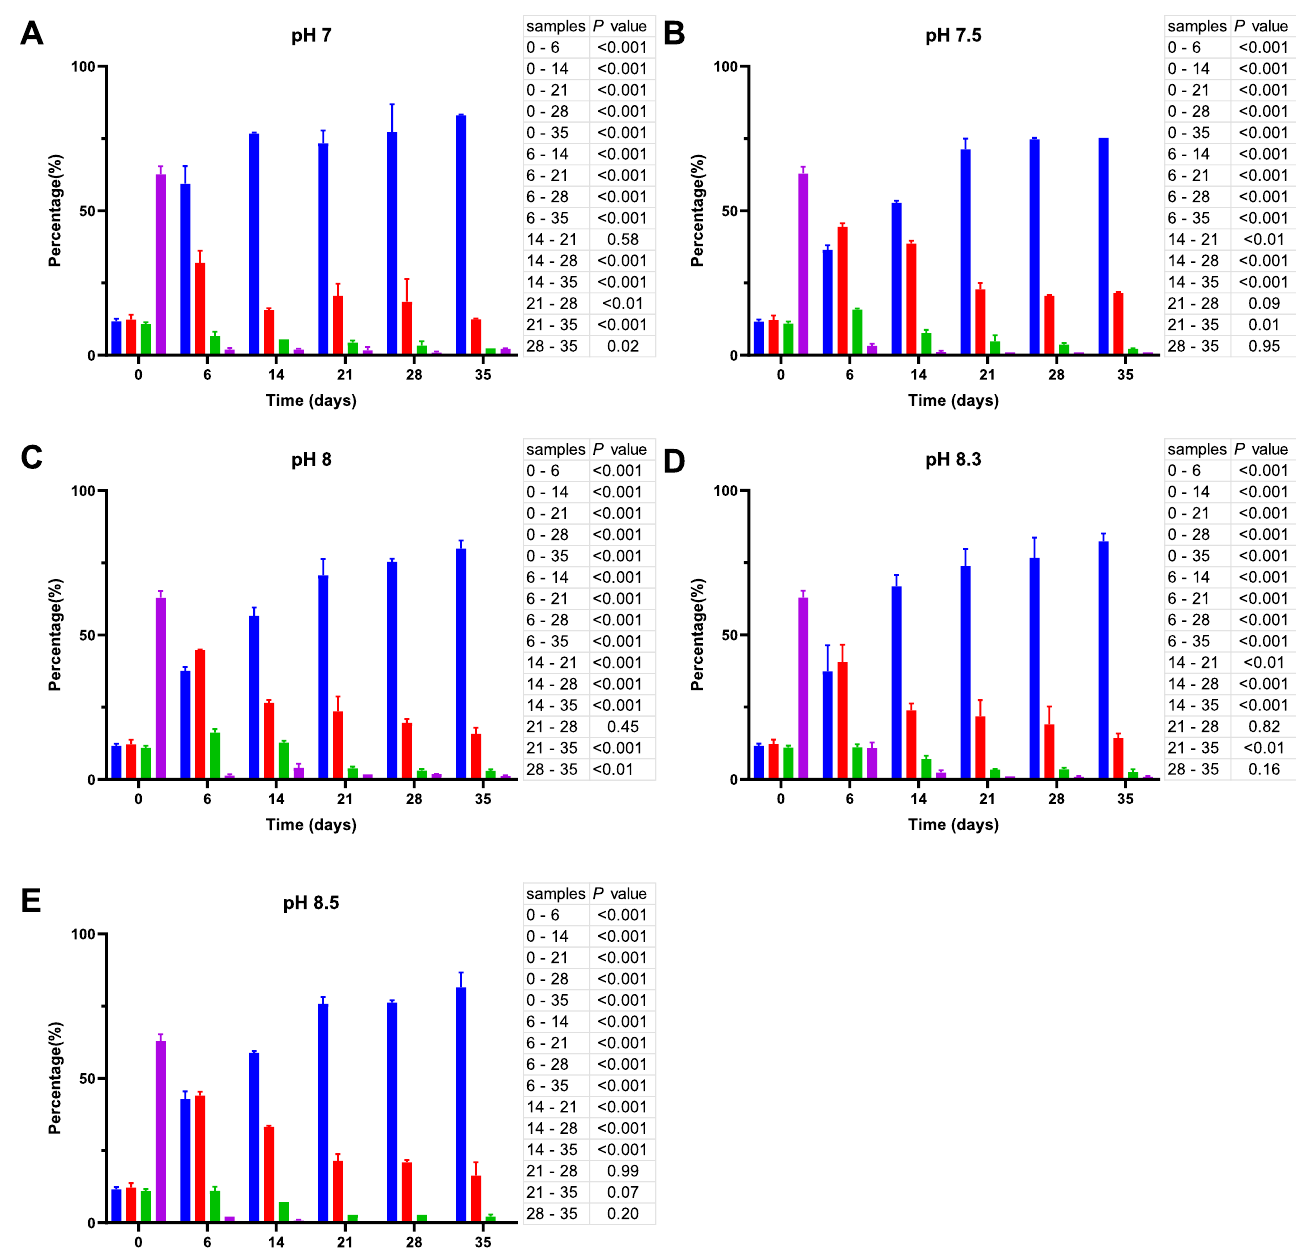
Figure 4. Cell size distribution at 20 °C. Cells are grouped according to their measured size ≤ 0.95 ( Figure 6. Cell size distribution at 30 ◦ C. Cells are grouped according to their measured size ≤ 0.95 Figure 6. Cell size distribution at 30 °C. Cells are grouped according to their measured size ≤0.95 █ ); >0.95– ≤ 1.3 ( ); >1.3–1.6 ≤ ( ); >1.6 ( ). The blue bars represent the population of coccoid-like ( █ ); >0.95 –≤1.3 ( █ ); >1.3 –1.6≤ ( █ ); >1.6 ( █ ). The blue bars represent the population of coccoid-like cells ( ≤ 0.95 µ m), whereas the cells with intermediate size and rod-like cells were arbitrarily placed in ). The blue bars represent the population of coccoid-like cells ( ≤ 0.95 μ m), whereas the cells with three additional groups indicated by red, green and violet bars. The data are mean values from three intermediate size and rod-like cells were arbitrarily placed in three additional groups indicated by independent experiments with error bars representing the standard deviations. Statistical tests were █ red, green and violet bars. The data are mean values from three independent experiments with error performed to carry out the pairwise comparisons of the cell sizes datasets and the corresponding p -values are shown on the right of each panel. ). The blue bars represent the population of coccoid-like cells ( ≤ 0.95 μ m), whereas the cells with intermediate size and rod-like cells were arbitrarily placed in three additional groups indicated by As shown in Figure 4, incubation of V. harveyi cells at 20 ◦ C promotes the reduction red, green and violet bars. The data are mean values from three independent experiments with error of their size during the first two weeks and this effect is observed at nearly all pH values except at pH 8.5. In other words, the percentage of coccoid-like cells ( ≤ 0.95 µ m) increases ). The blue bars represent the population of coccoid-like cells ( ≤ 0.95 μ m), whereas the cells with up to 85–90% after 6–14 days and this result is supported by statistical data ( p < 0.001). intermediate size and rod-like cells were arbitrarily placed in three additional groups indicated by red, green and violet bars. The data are mean values from three independent experiments with error However, incubation for a longer time (21–35 days) reverses this effect, thus leading to